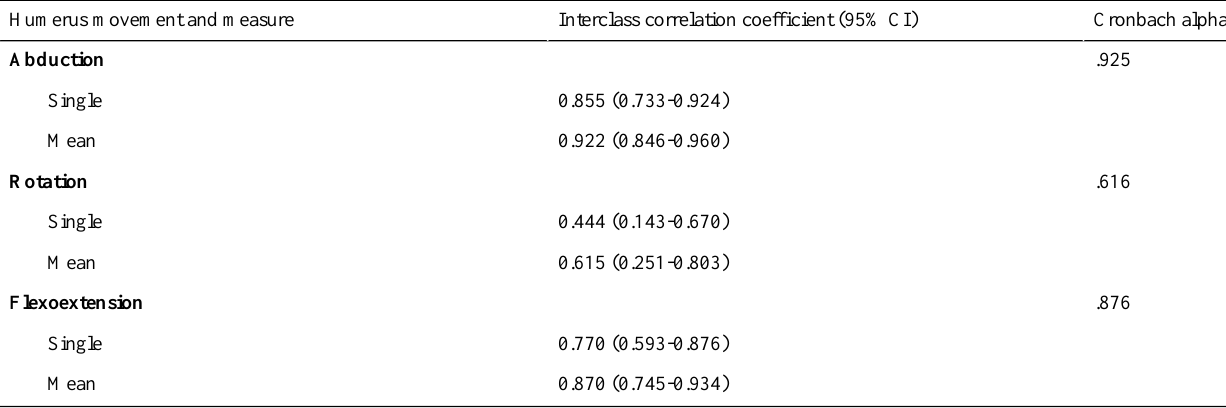
Table 4. Interclass correlation coefficient interdevices for flexion movement.